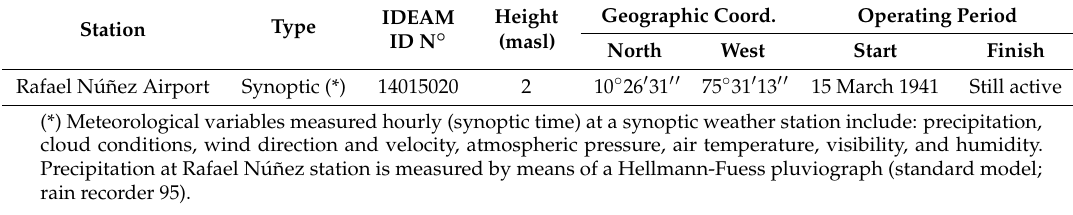
Table 2. Description of Rafael N ú ñez airport weather station. Geographic Coord. Operating Period Height IDEAM Station Type (masl) ID N ◦ North